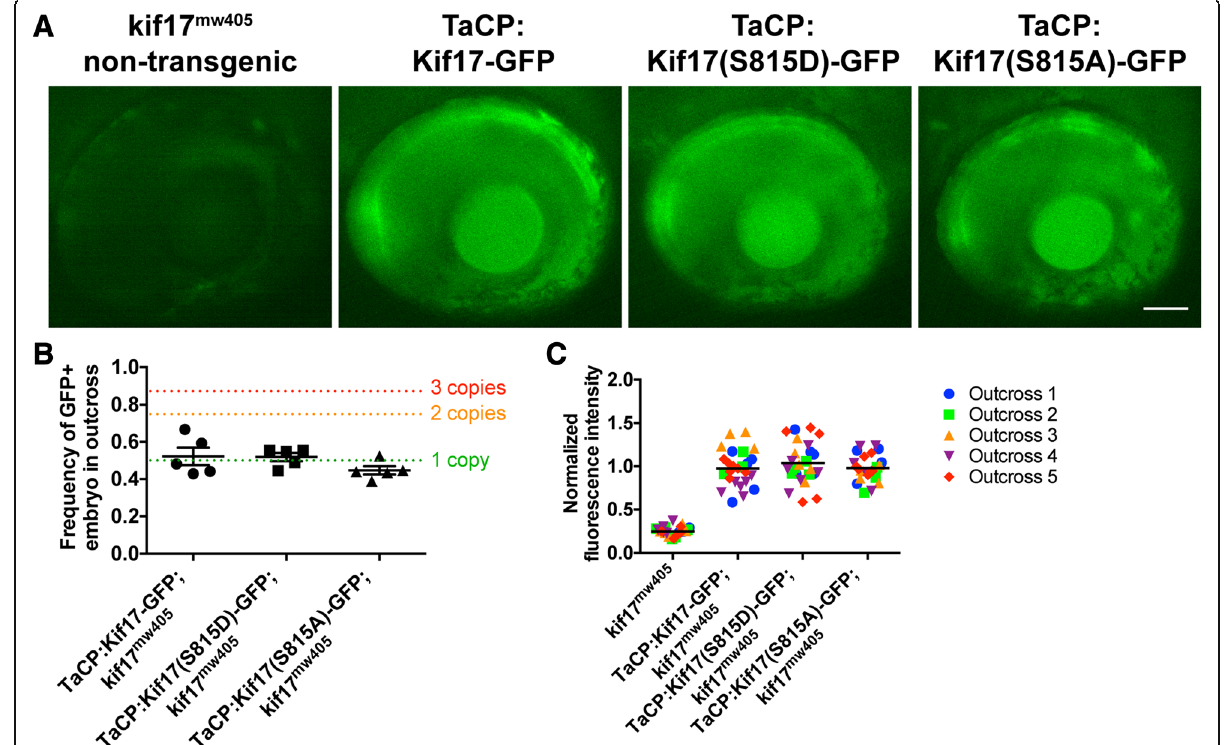
Fig. 3 Establishment of stable lines of Kif17 transgenic zebrafish. a The three stable transgenic lines of zebrafish were outcrossed to kif17 mw405